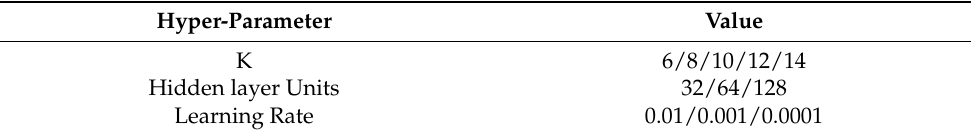
Table 5. The range of values for the hyper-parameters.